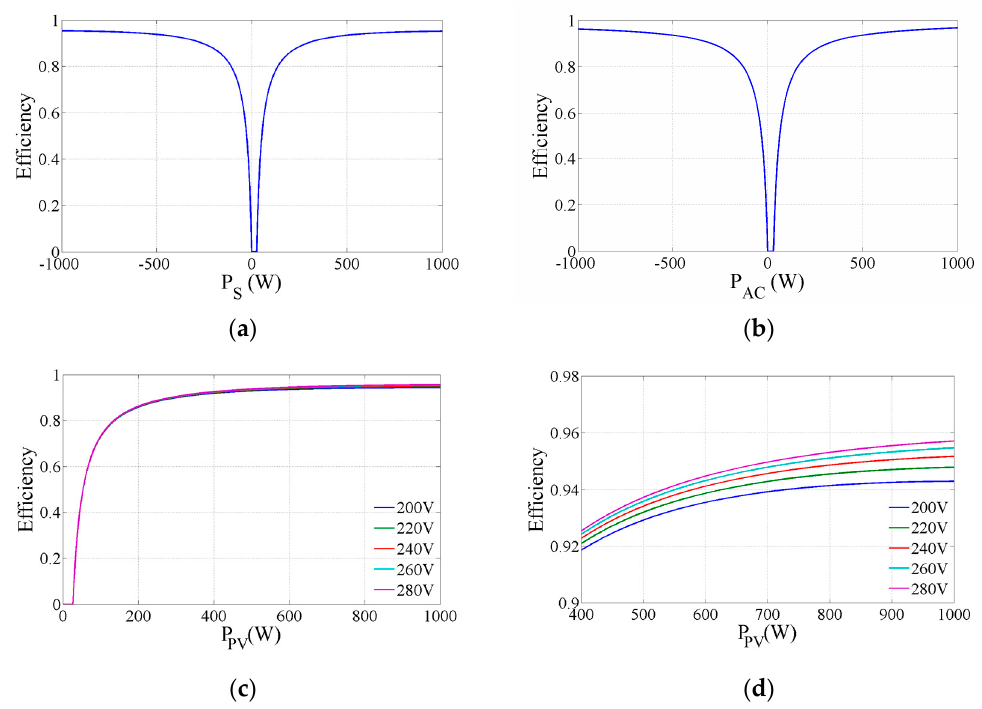
Figure 4. Converter efficiency curve obtained by the estimation: ( a ) half bridge DC/DC converter efficiency versus storage power; ( b ) full bridge DC/AC converter efficiency versus grid power when v G _ RMS = 230V; ( c ) half bridge DC/DC converter efficiency versus PV power for different PV generator voltages; ( d ) zoomed view of PV converter efficiency for different PV generator voltages.